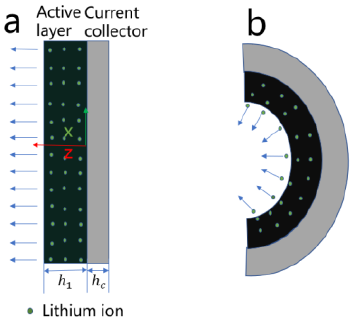
Figure 3. The structure of the electrode, wherein an active plate is combined with the current col- lector (( a ) initial state and ( b ) deformation state). (( a ) initial state and ( b ) deformation